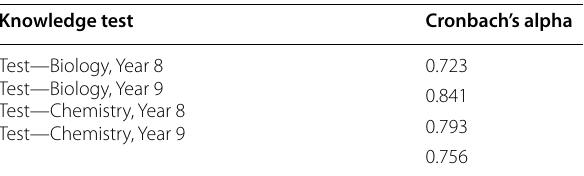
Table 6 Reliability statistics of knowledge tests (Cronbach’s alpha) Knowledge